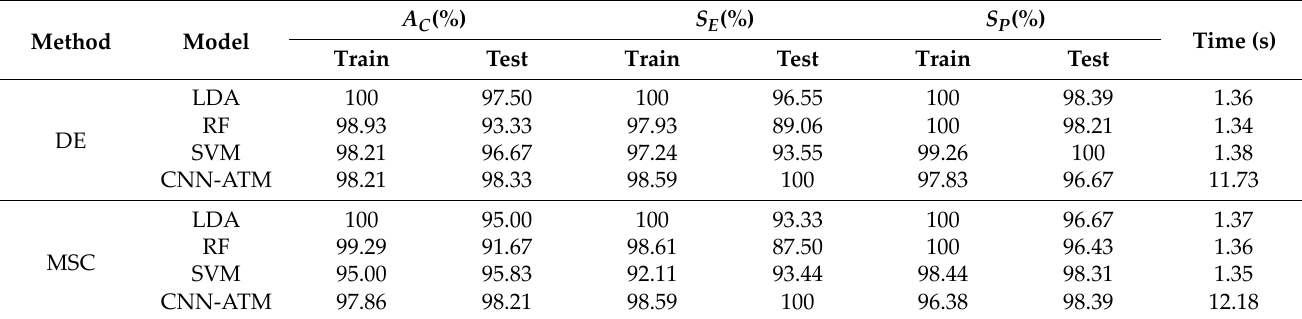
Table 2. Detection results based on full